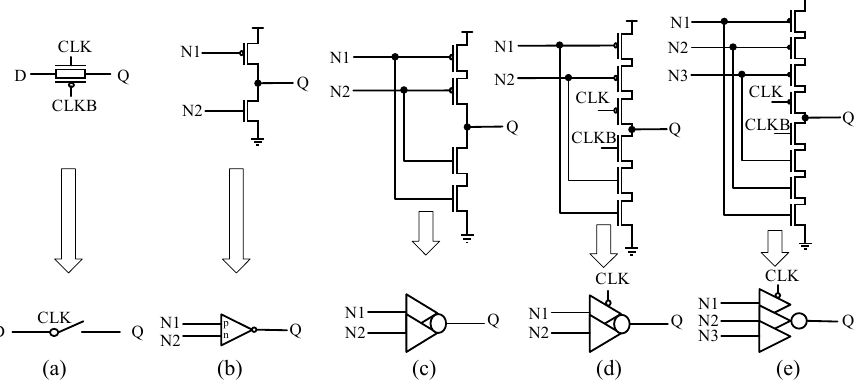
Figure 1. Several typical units: ( a ) transmission gate (TG); ( b ) two-input inverter; ( c ) two-input C-element; ( d ) CG-based two-input C-element; ( e ) CG-based three-input C-element.